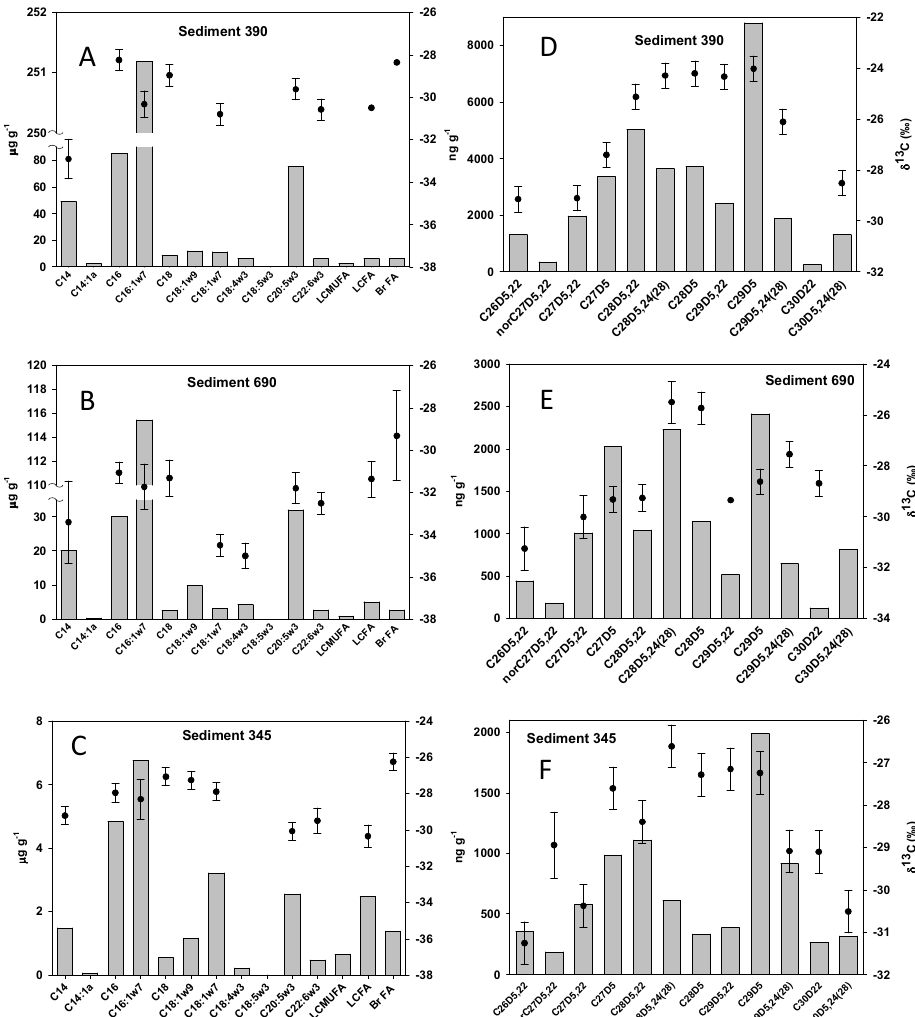
Fig. 6. Concentrations (bars) and carbon isotopic ratios (mean ± SD, n = 3) of selected fatty acids (A–C) and sterols (D–F) in selected sediments from the Mackenzie Shelf and